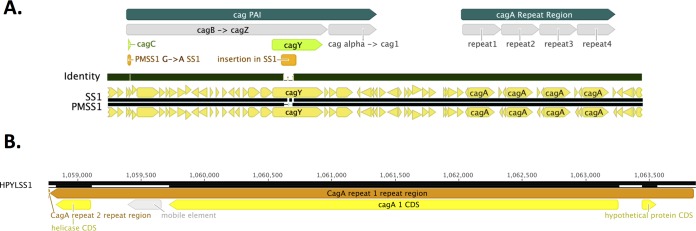
The cag PAI and cagA regions possess only two sequence differences between SS1 and PMSS1. (A) Diagram shows an alignment of the cag PAI and cagA regions of SS1 and PMSS1, with a dark green middle “identity” bar indicating their genetic identity. The two regions that differ—in cagY and cagC—are indicated and detailed in Table 2. (B) Diagram showing a single cagA repeat, with the cagA gene, promoter region, and two open reading frames (hypothetical and helicase).